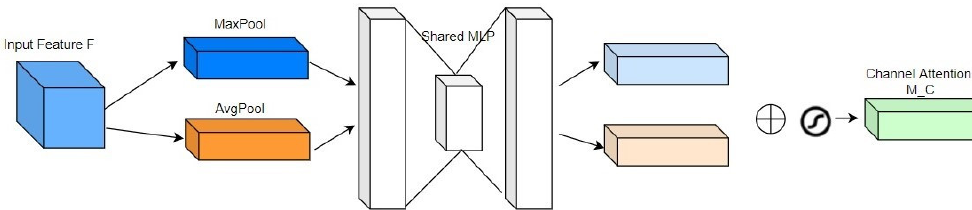
Figure 4. CAM Structure Diagram.